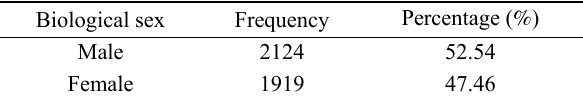
Table 2 Descriptive analysis of biological sex factor.